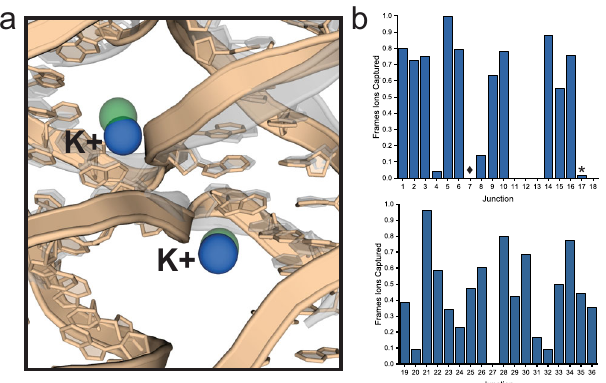
Fig. 5 MD simulations relate capture of ions with lattice formation. a Superimposed structures of the 4 × 5 J10 crystal structure (translucent gray) with a snapshot from the J10 simulation in solution (tan). The arsenic binding sites (green spheres) in the crystal structure near the branching point overlap with spontaneously formed potassium (blue spheres) binding sites in the solution structure simulations. b Graphs showing the incidence of ion capture near the branching point in simulations of all 36 junction sequences. The consensus “ fatal ” junctions (J11, 12, 13, 17, 18, and 27) show no ability for ion capture with the exception of J17 (asterisk) which did so to a negligible degree compared to the crystallizing junctions. All other junctions resulting in crystals demonstrated the ability for ion capture to a signi fi cant degree, with only a single outlier (J7, diamond). J7 robustly crystallized, but showed no ability to capture ions in both experiments and simulations, suggesting the ion binding is not essential for crystallization of this single junction.